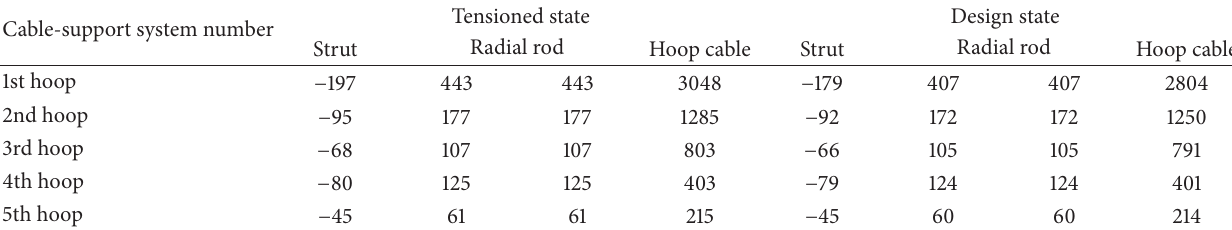
Table 4: Axial force of cable-support systems in construction simulation